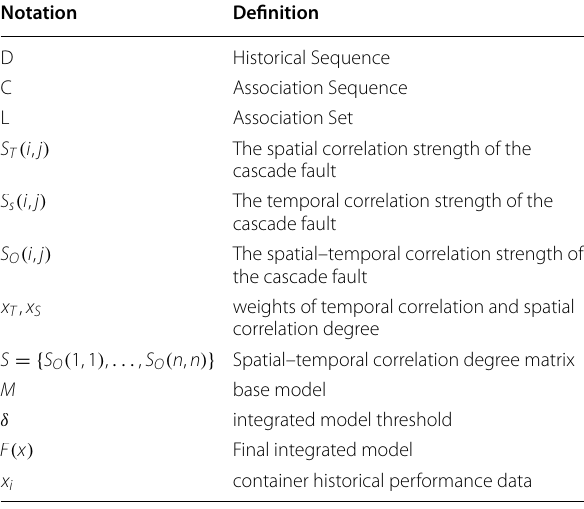
Table 1 Types and methods of fault